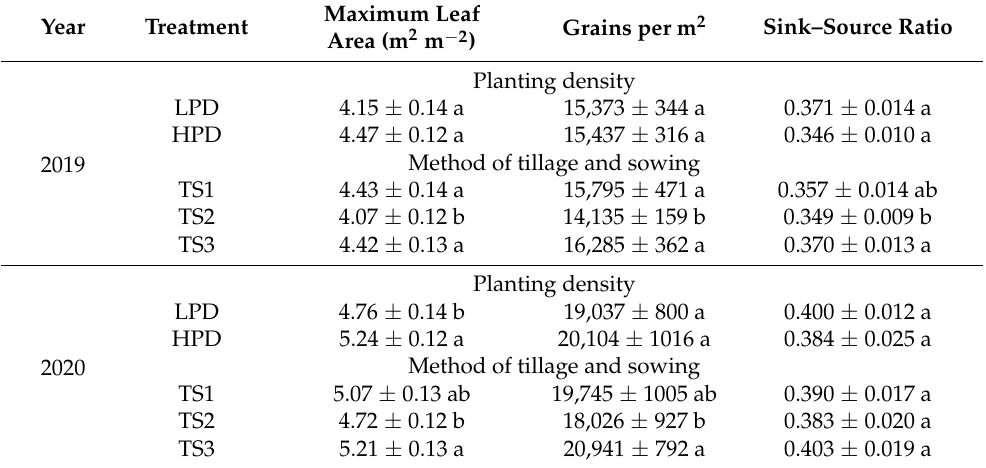
Data are means ± standard errors. Different letters indicate significant differences between/among the treatments at the 0.05 probability